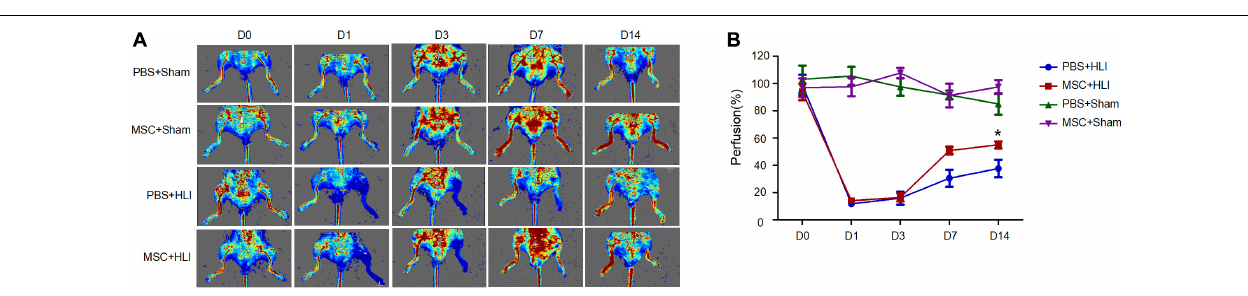
FIGURE 2 | MSC transplantation promoted blood flow recovery in ischemic hindlimbs of mice. (A) LDPI measurement of hindlimb blood flow at days 0, 1, 3, 7, and 14 after ischemic surgery, presented as representative images. Colors represent the perfusion degree: red, highest velocity; green, intermediate; blue, low velocity. (B) Quantitative analysis of the blood flow perfusion ratio of ischemic-to-non-ischemic hindlimbs at days 0, 1, 3, 7, and 14, respectively ( n = 3). MSC + HLI, mutant MSCs transplanted to HLI; MSC + Sham, mutant MSCs transplanted to Sham; PBS + HLI, PBS transplanted to HLI; PBS + Sham, PBS transplanted to Sham. * p <